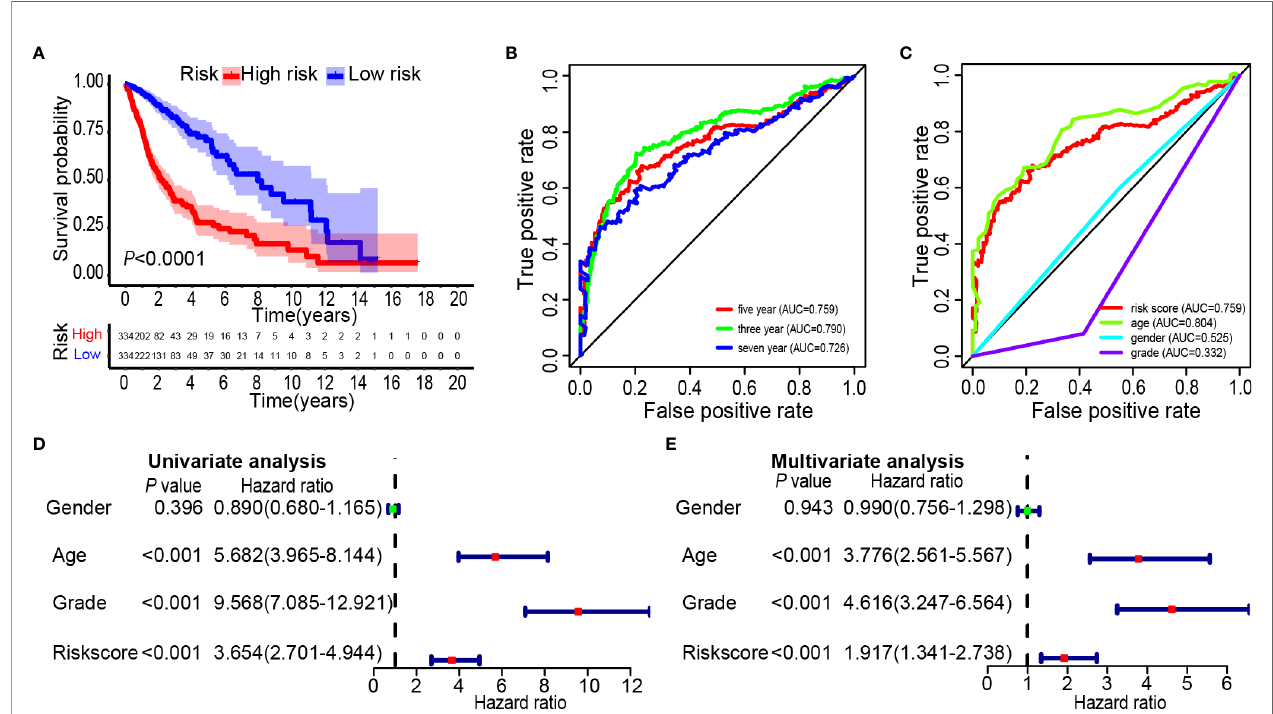
FIGURE 6 | Prognostic signi fi cance of the 25-gene signature derived risk scores in TCGA cohort. (A) Kaplan-Meier analysis of TCGA gliomas patients was strati fi ed by median risk. High-risk scores are associated with general poor survival of gliomas. (B , C) Multi-index ROC curve of risk score and other indicators. (D) Univariate Cox regression analysis. Forest plot of associations between risk factors and the survival of gliomas. (E) Multiple Cox regression analysis. The ferroptosis-related gene signature is an independent predictor of gliomas.